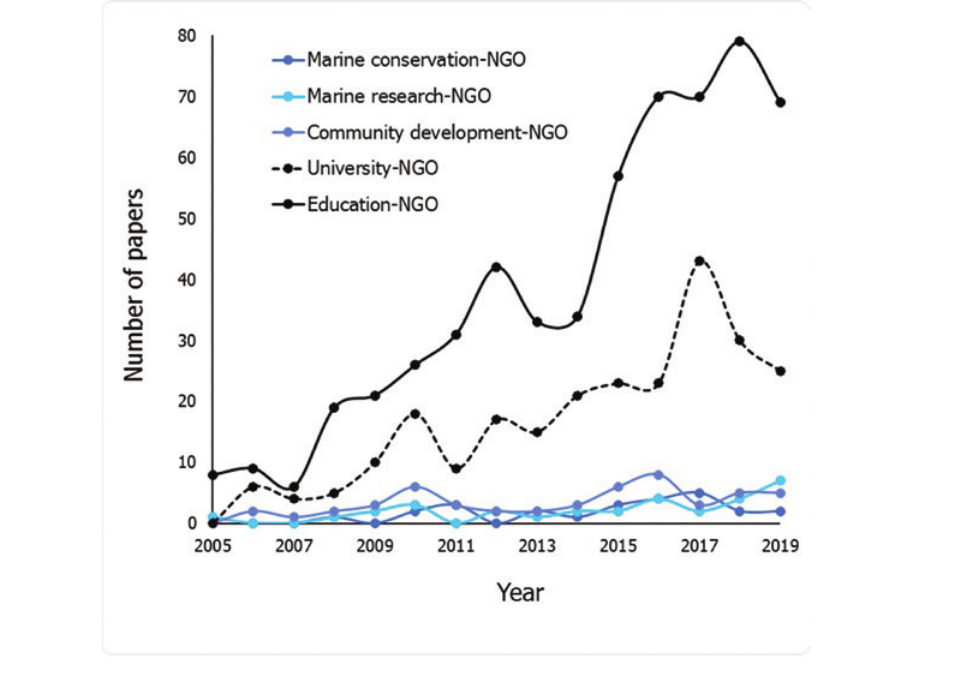
figure 1: Number of manuscripts from the last 15 years (Web of science, accessed 20 July 2020, https://login.webofknowledge.com/) containing in the title, keywords and/or abstract each of the paired search terms shown in the figure legend (credit: